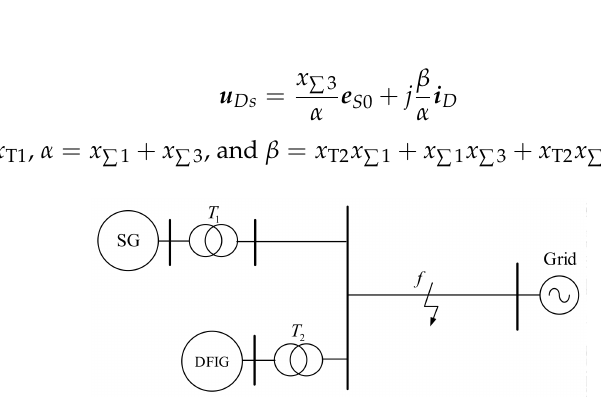
Figure 1. Structure of double-machine system.